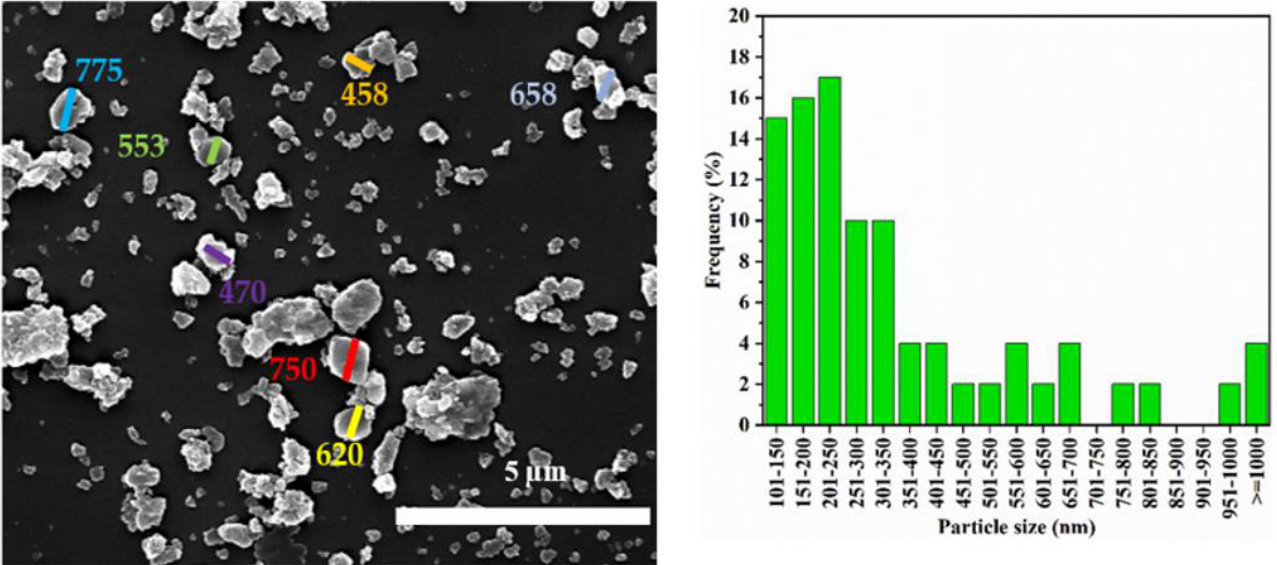
Figure 3. SEM image (left) and particles size distribution (right) of ball-milled zeolite Y without CNF.